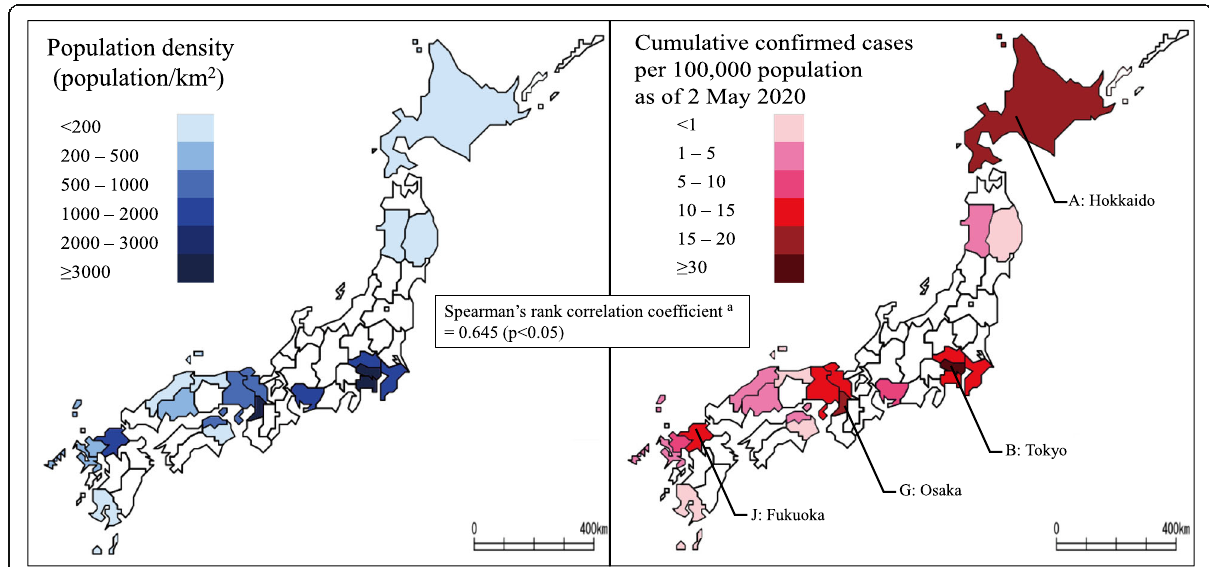
Fig. 2 Population density and cumulative COVID-19 cases per 100,000 population in the study areas. a Due to non-normal distribution of data,